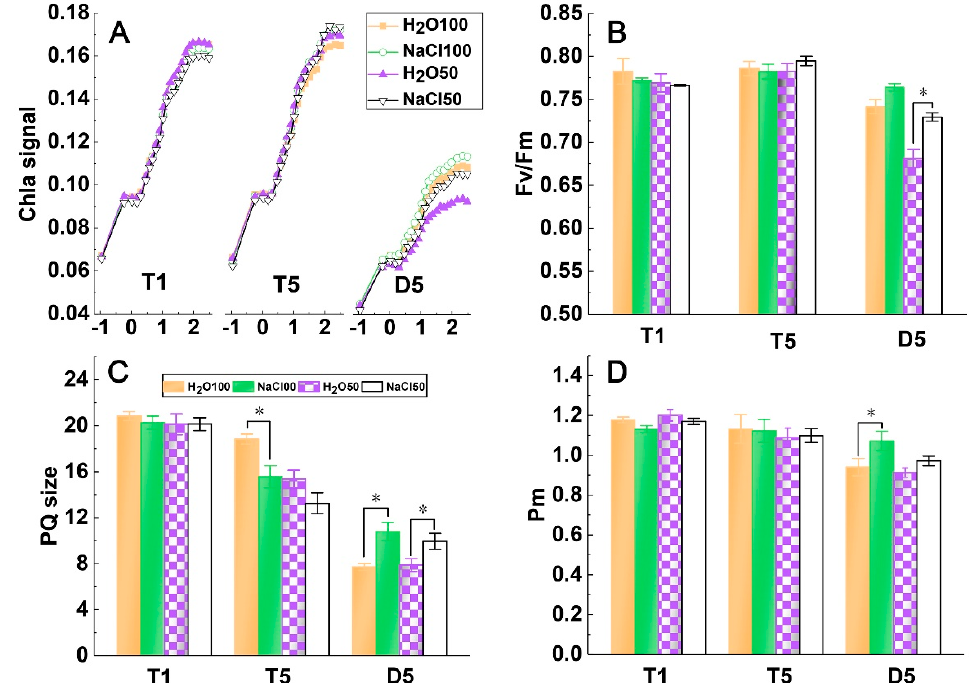
Figure 2. The e ff ect of soil salinity on the photosynthetic activity of PSI and PSII of tomato leaves under subsequent drought stress. The fast induction curve of chlorophyll a fluorescence ( A ), the maximal quantum e ffi ciency of PSII (Fv / Fm) ( B ), plastoquinone (PQ) size ( C ) and the maximal redox state of PSI (Pm) ( D ) of tomato leaves under subsequent drought stress. The pattern in ( A ) represents the redox kinetic curve of P700. T1, the first day following soil salt pre-treatment; T5, the fifth day following soil salt pre-treatment; D5, the fifth day after the subsequent drought treatment. The results are displayed as mean values of three independent biological replicates, means ± SD, * P < 0.05, student’s